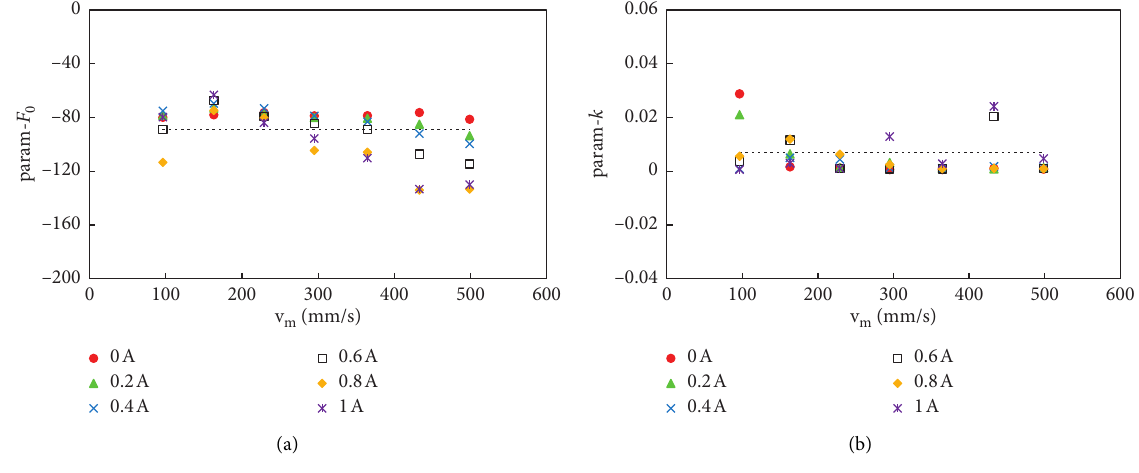
Figure 17: Identification results of parameters F